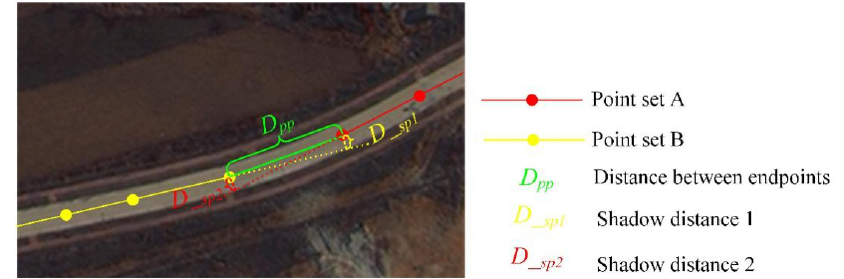
Figure 8. Schematic diagram of merging and connecting road center points.